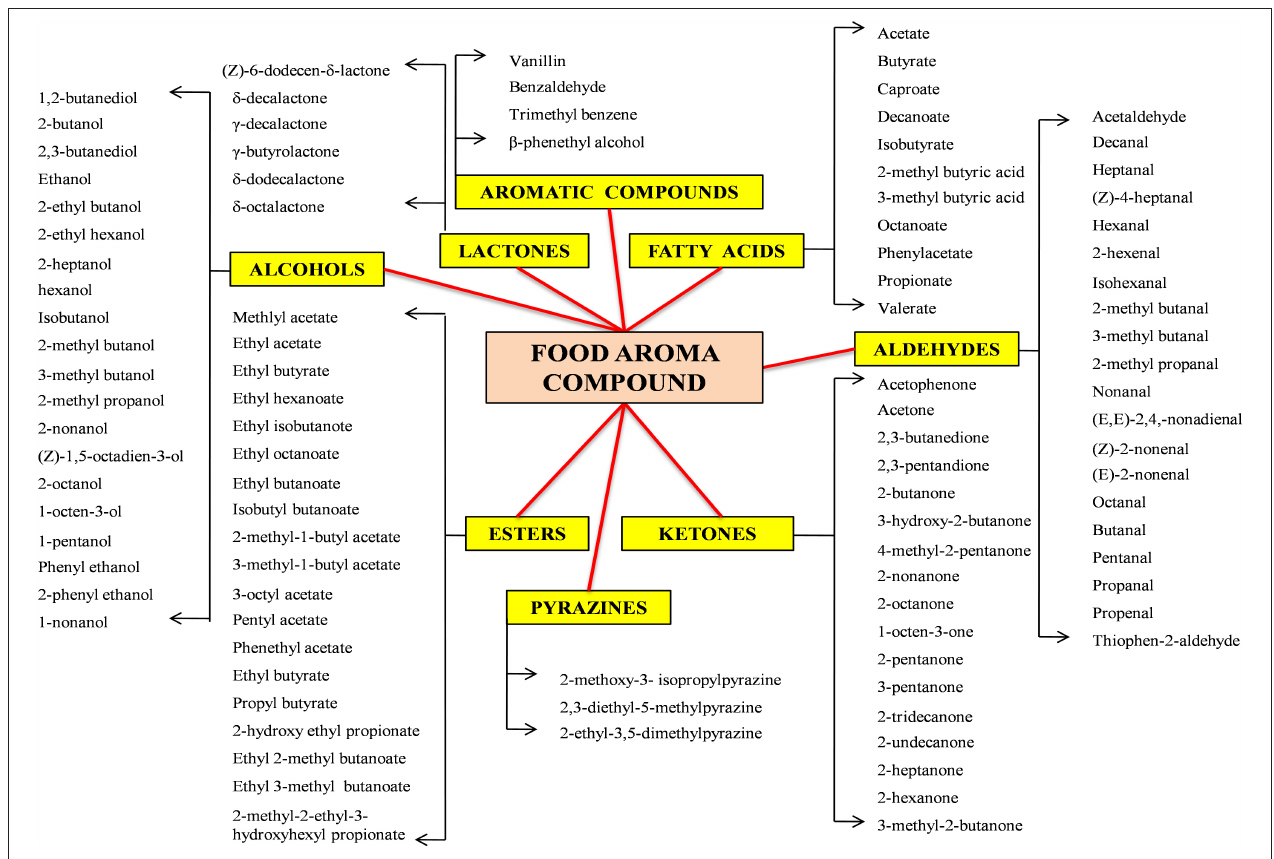
FIGURE 2 | Classification of flavor compounds on the basis of chemical